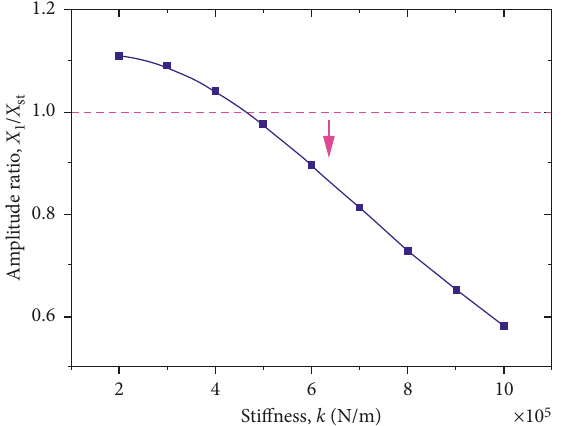
Figure 10: Amplitude ratio of the optimal